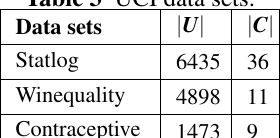
Table 3 UCI data